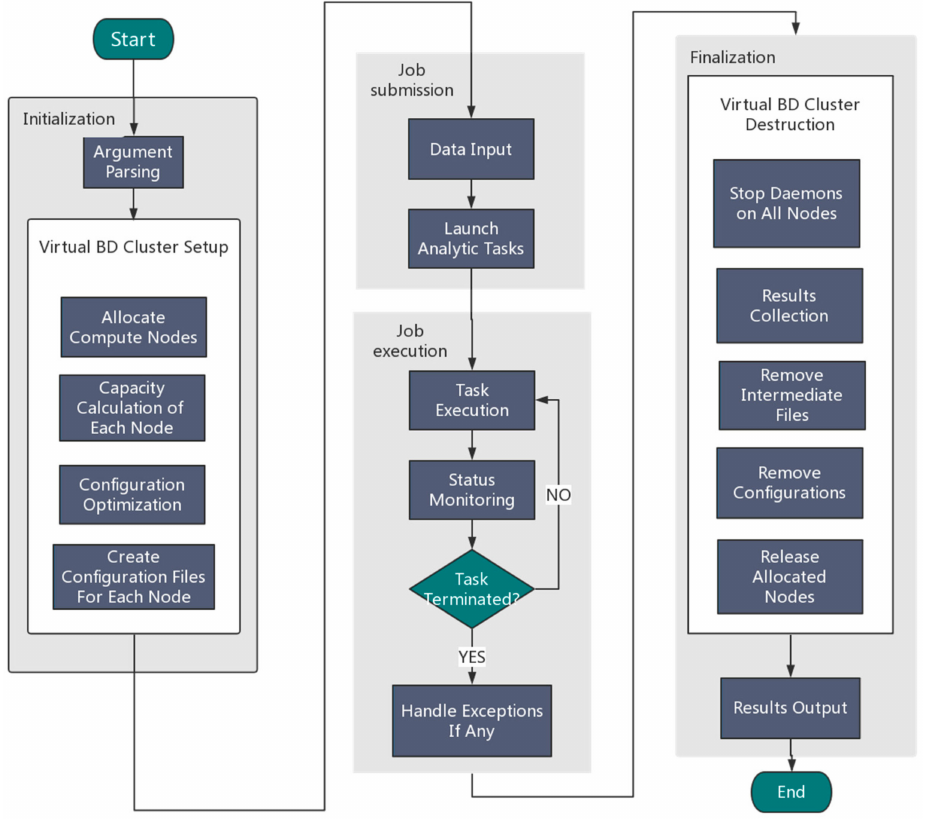
Figure 2. An overview of the Orion architecture for big data